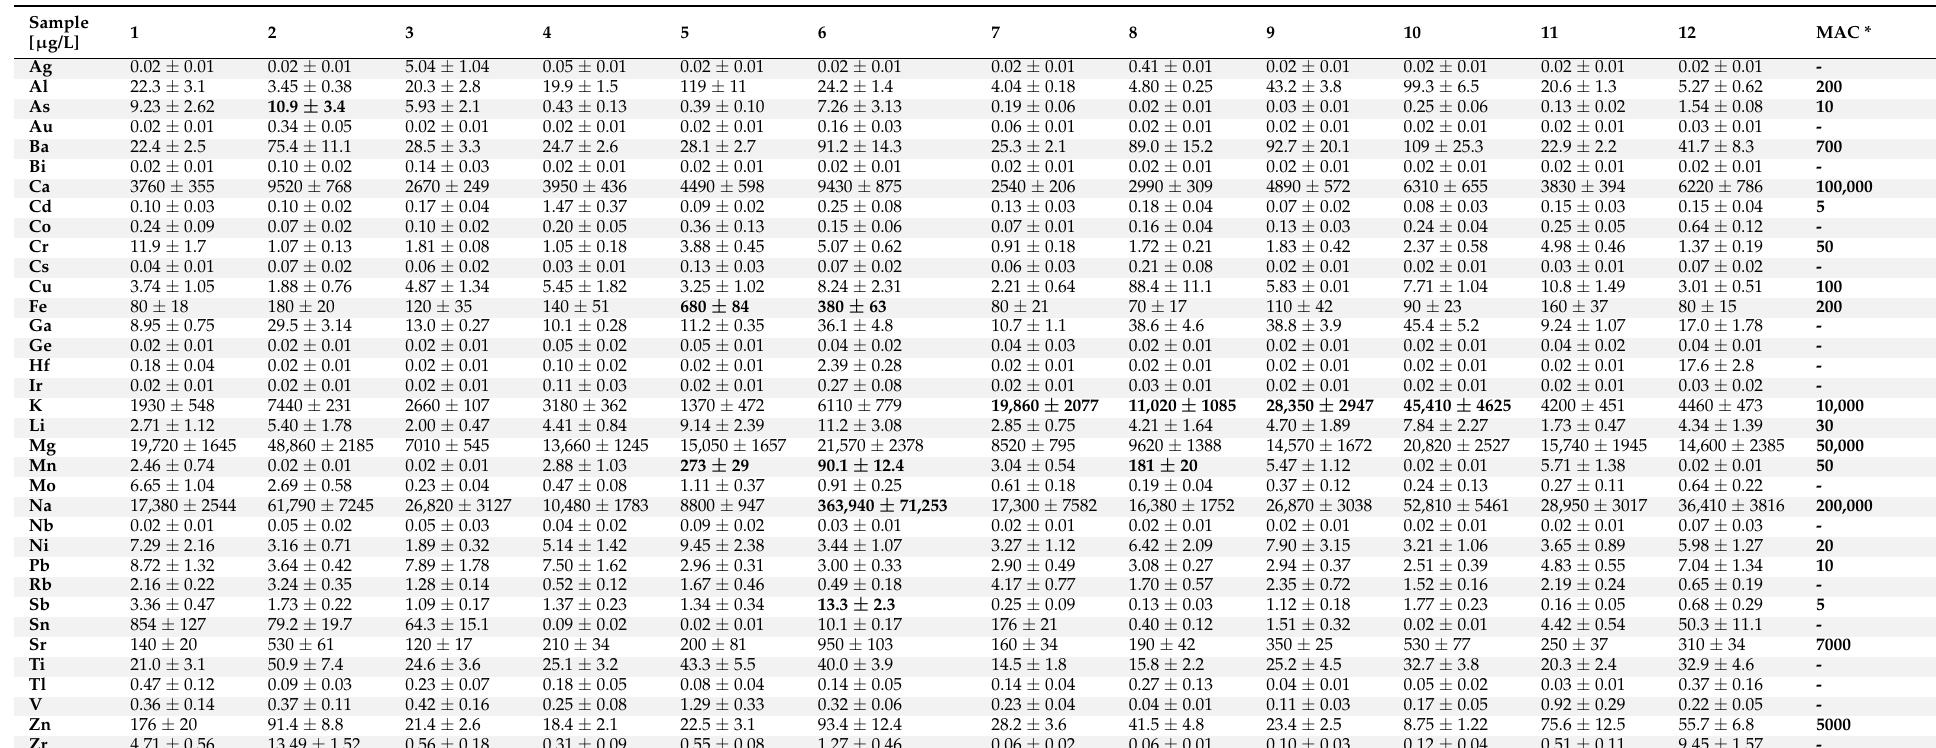
Table 2. The metals and heavy metals characteristics (mean ± standard deviation) of the studied water